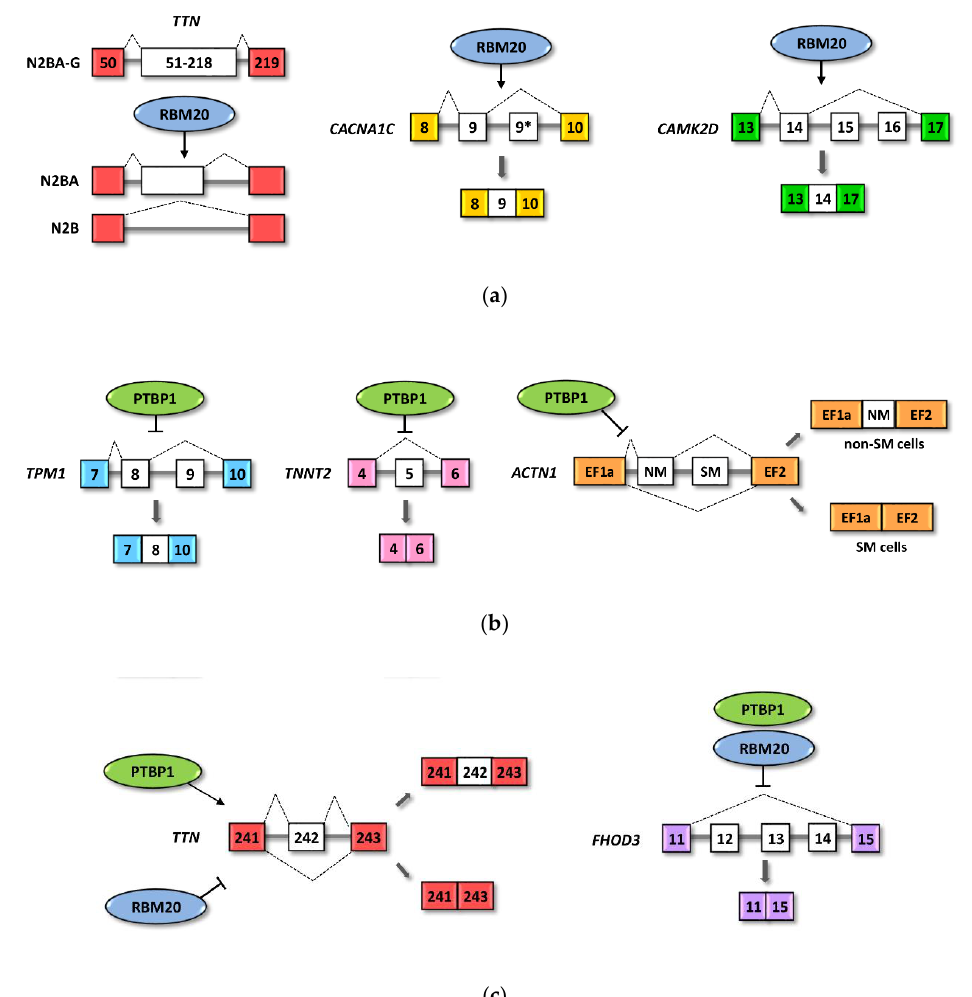
Figure 2. Schematic representation of examples of pre-mRNAs regulated by RBM20 and PTBP1. Colored exons represent constitutively spliced exons, while white exons represent alternative exons. ( a ) TTN (titin), CACNA1C (Calcium Voltage-Gated Channel Subunit Alpha1 C) and CAMK2D (Calcium / Calmodulin Dependent Protein Kinase II Delta) are examples of pre-mRNAs regulated by RBM20. ( b ) TPM1 ( α -tropomyosin), TNNT2 (Troponin T2, Cardiac Type) and ACTN1 ( α -actinin) are examples of pre-mRNAs regulated by PTBP1. ( c ) TTN (titin) and FHOD3 (Formin Homology 2 Domain Containing 3) are examples of pre-mRNAs regulated by both PTBP1 and RBM20.